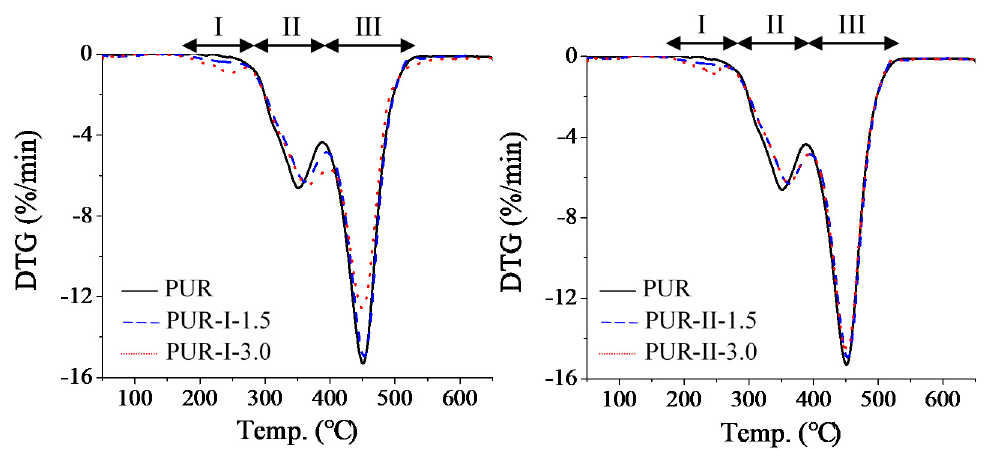
Figure 7. TGA curves of various cured PUR. Figure 7 . TGA curves of various cured PUR. Figure 7 . TGA curves of various cured PUR.